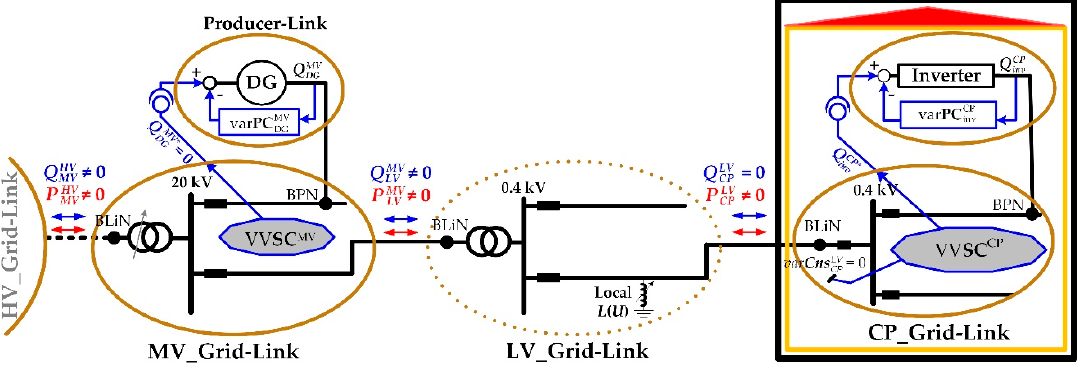
Figure 6. Simplified form of the VVC chain strategy representing the setup with L ( U )-control and CP_ Q -autarky.